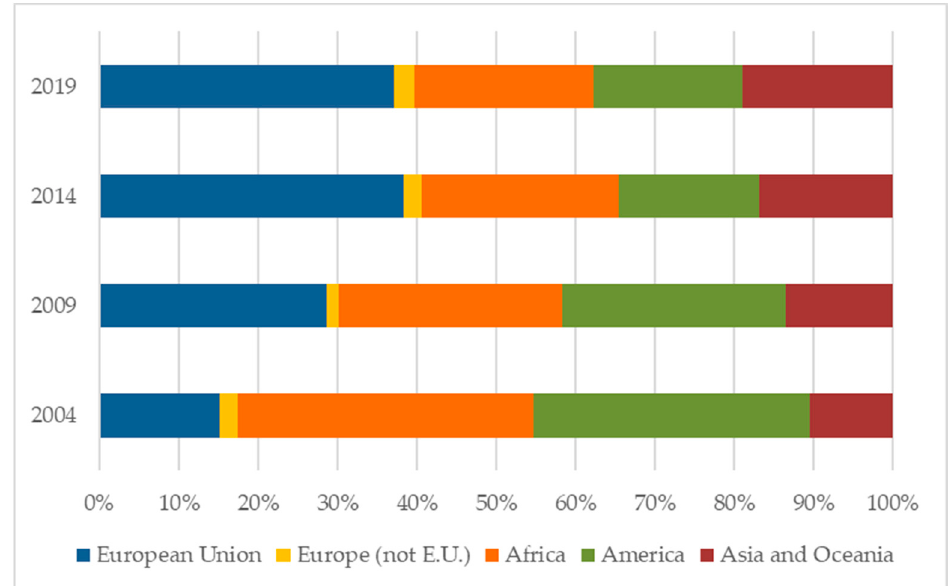
Figure 4. Evolution of the foreign population in Santa Catalina-Canteras. Source: Own elaboration based on the Continuous Population Register (National Statistics Institute).